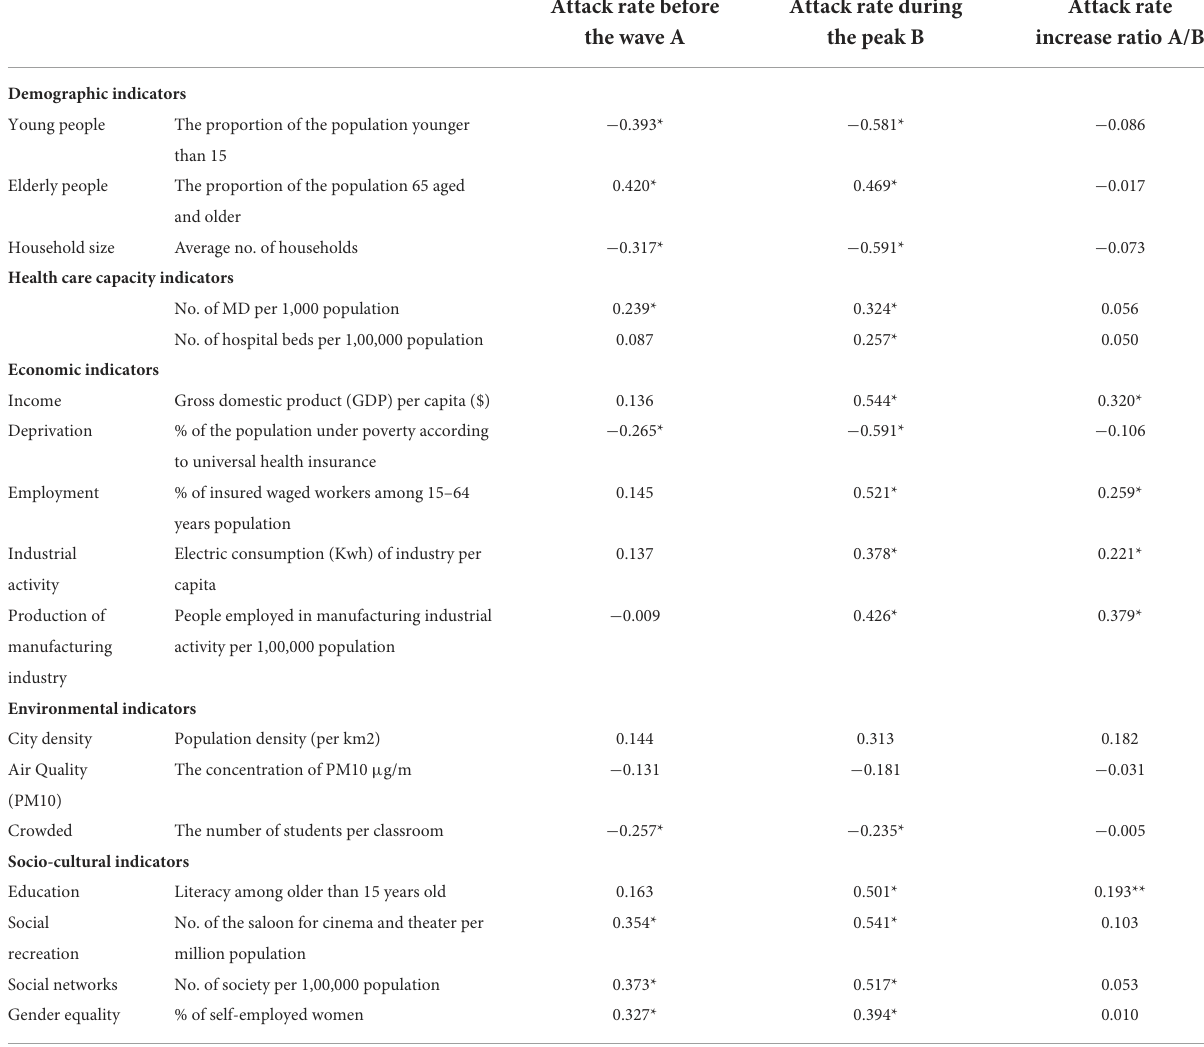
TABLE 3 The bivariate correlations between the attack rates and urban indicators in the third wave of the COVID-19 outbreak in Turkey.